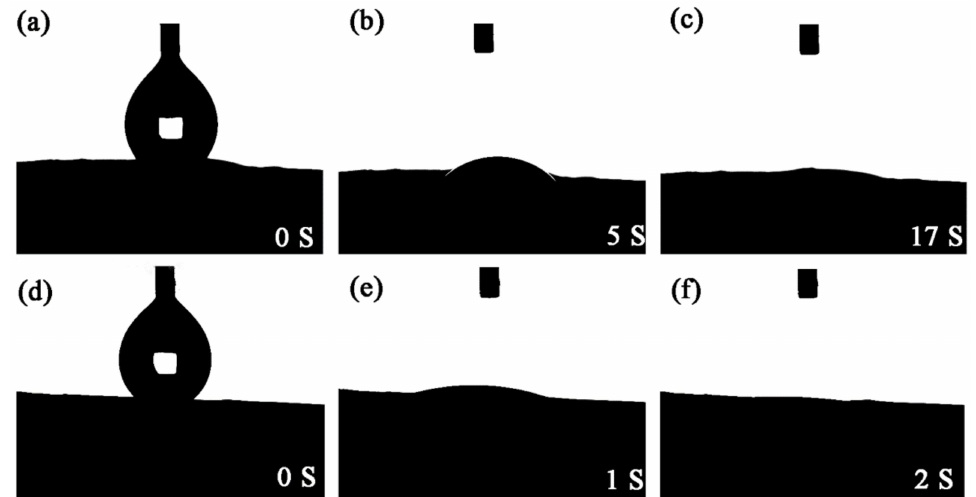
Figure 6. Photos of dynamic measurements of water spreading for PAN ( a – c ) and PDA@PAN ( d – f ) electrospun nanofibrous